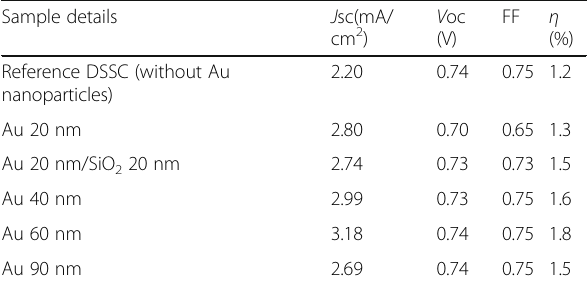
Table 1 Photovoltaic properties of DSSCs with and without